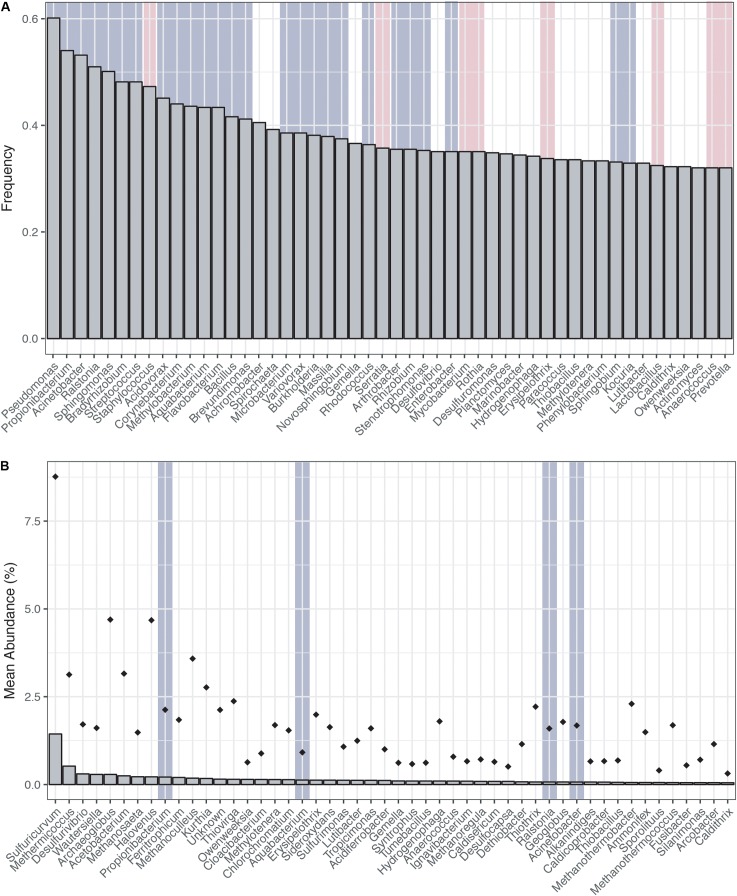
Distribution of top genera from the Census of Deep Life dataset (all publically available data as of May 2017). (A) Genera ranked by frequency (left to right, most frequent to least frequent). (B) Genera ranked by mean abundance (left to right, most abundant to least abundant). Abundance was calculated on a per sample basis. Diamonds represent the upper maximum standard deviation. Vertical gray highlighting bars indicate genera identified as putative contaminants by previous studies and pink vertical bars represent other contaminants generally associated with the human microbiome.